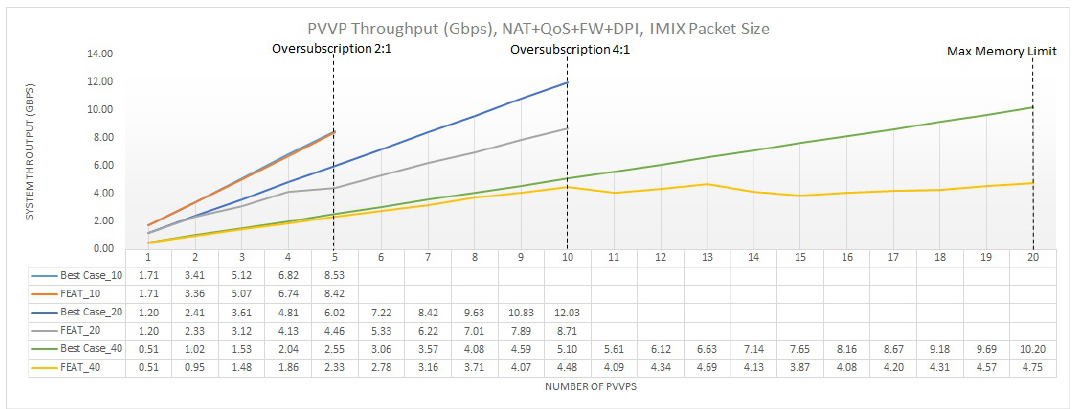
Figure 16. Multi-Feature multi-PVVP system throughput with NAT, QoS, FW, and DPI.